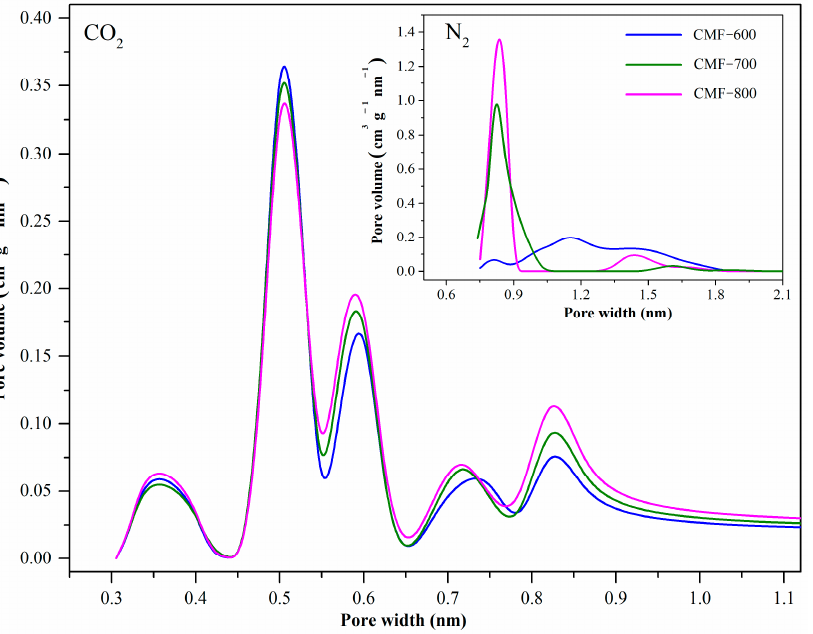
◦ C) and N − 196.15 ◦ C) for carbon 2 (0 2 (